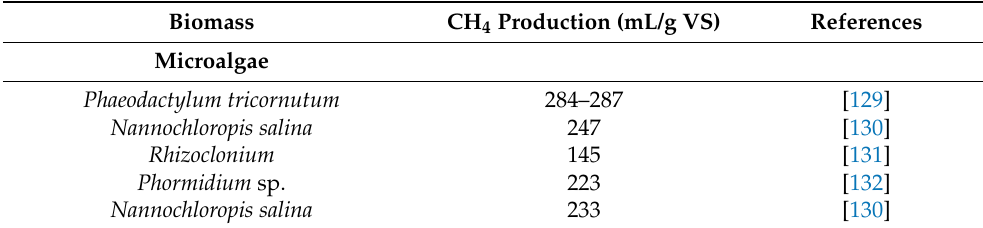
Table 5. Comparison of pre-treated microalgae, lignocellulosic biomass, and unpretreated seaweed biomethane